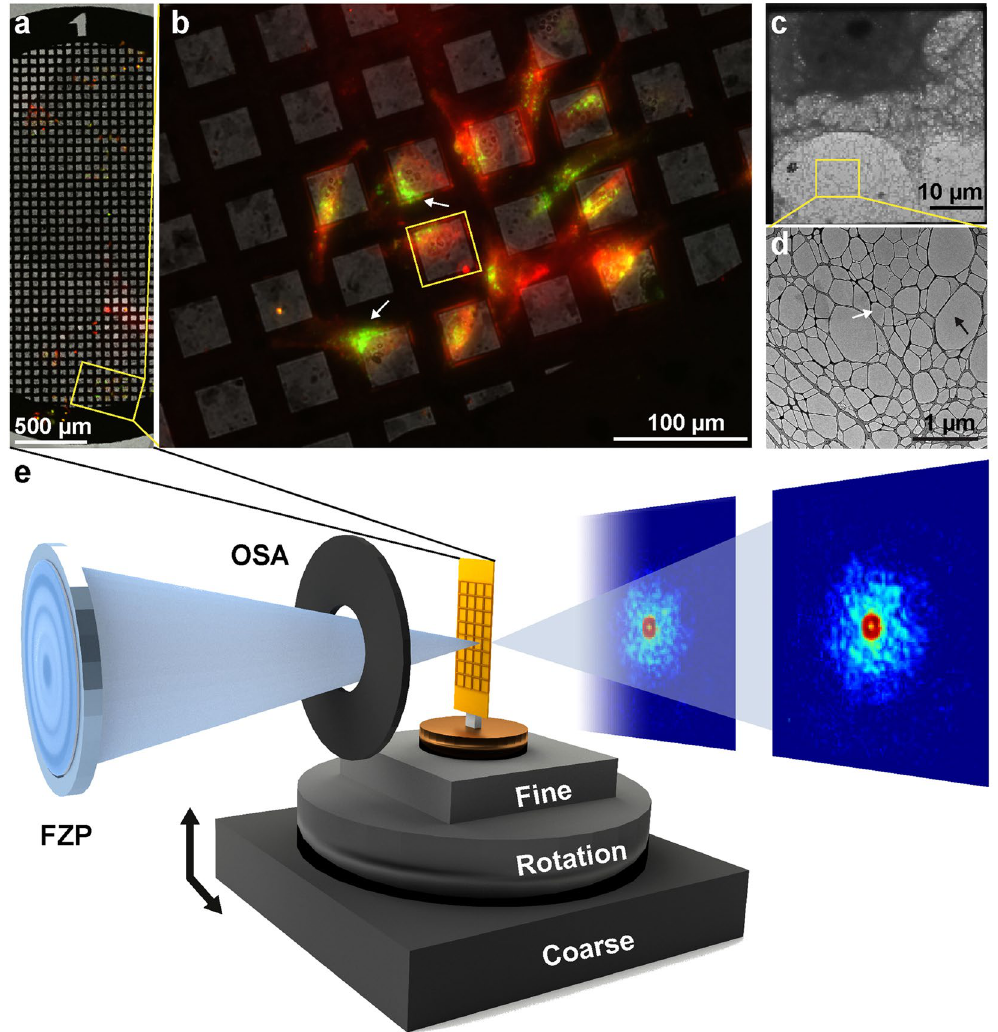
Figure 1. Experimental setup for correlative microscopy. ( a ) Composite fluorescent image of HeLa cells grown on graphene-oxide coated lacey carbon TEM grid. Cells were labeled with CMPTX (red) to facilitate tracking and treated with FITC labeled core-shell nanoparticles (green). ( b ) A magnified view of a region from this grid shows cells labeled with a tracking dye as well as fluorescent core-shell nanoparticles. White arrows point to cellular inclusions with clusters of fluorescent nanoparticles. ( c ) Electron micrograph of a portion of a HeLa cell covering an individual grid window, similar to the region highlighted in ( b ). ( d ) Magnified view of the lacey carbon grid. The black arrow points to empty regions of the grid whilst the white arrow indicates thin layers of graphene- oxide. ( e ) Experimental setup at BL 5.3.2.1 used for STXM/ptychographic imaging with key components labeled. The X-ray beam is focused using a Fresnel zone-plate (FZP) with all but the first order blocked by an order-sorting aperture (OSA). The focused beam is rastered across the sample using high-precision stages under interferometric feedback and diffraction patterns are captured by a fast-CCD at each scan